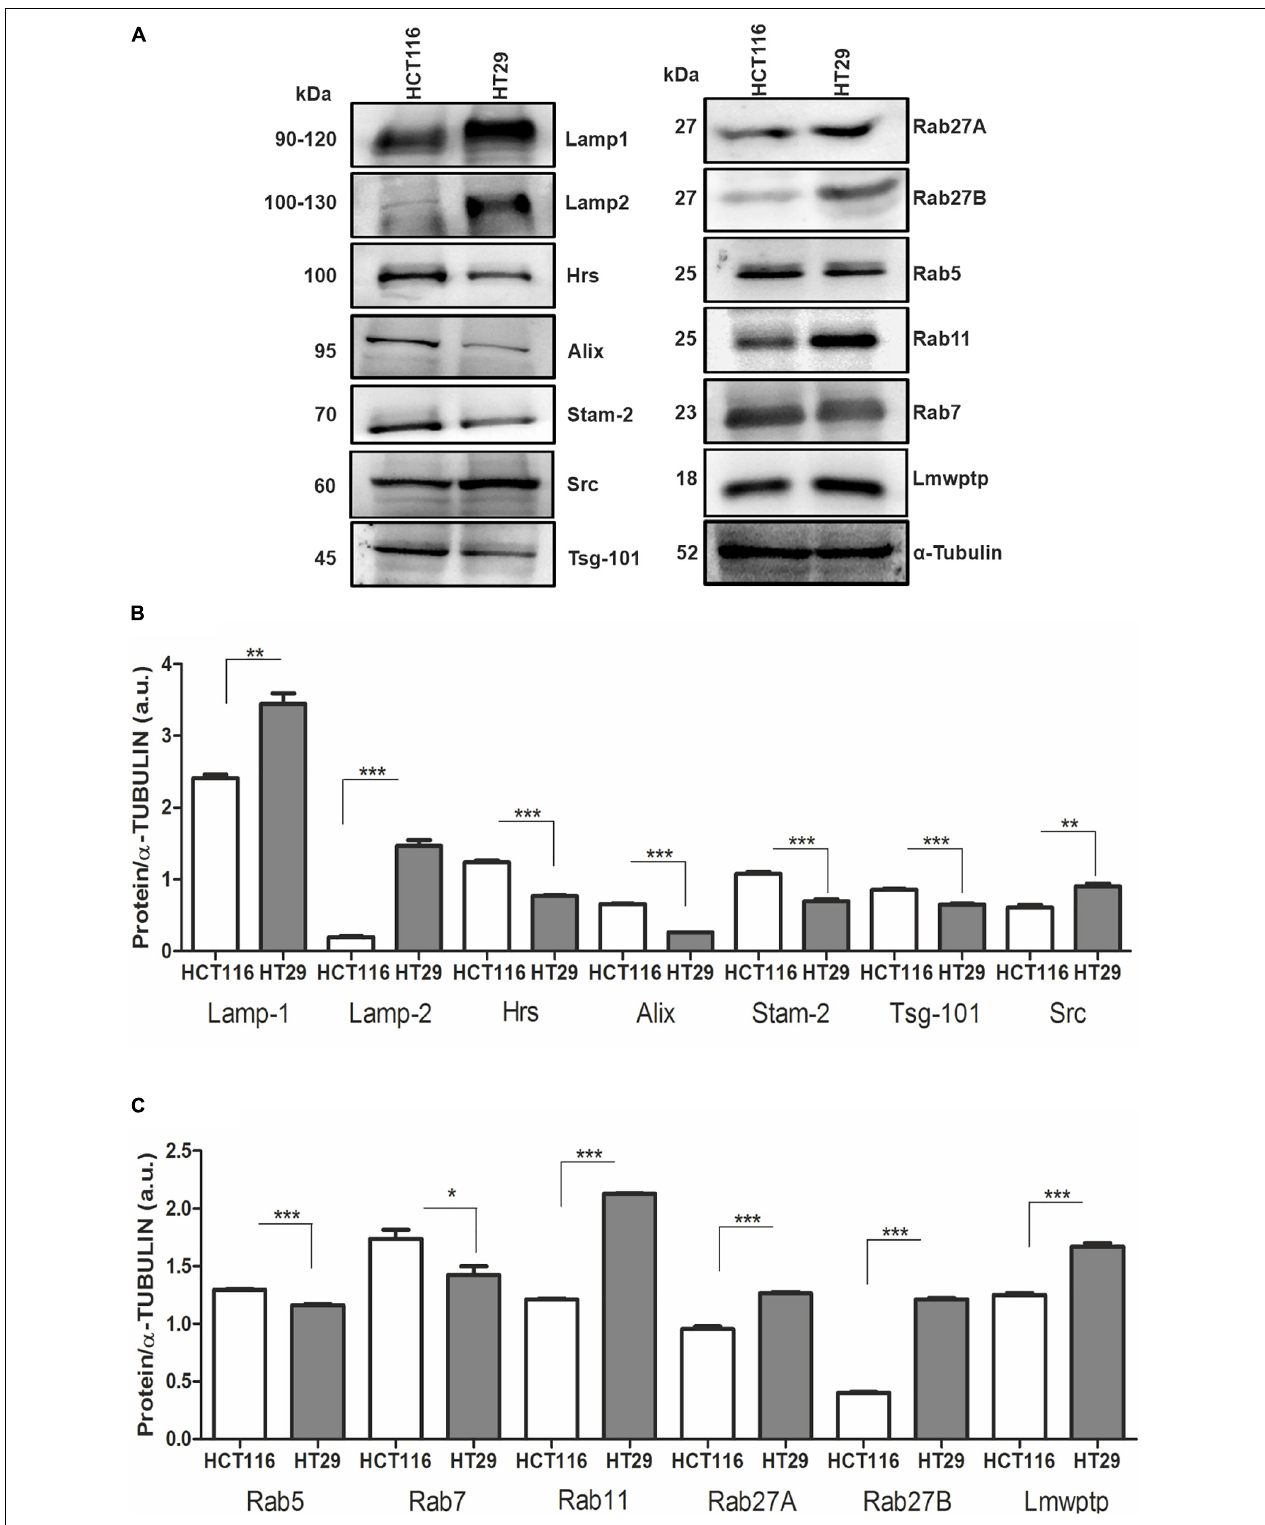
FIGURE 2 | Protein profile from HCT116 and HT29-sEV donor cells. (A) Representative images of Western blotting analysis performed for the indicated proteins. α -Tubulin serves as a loading control. (B,C) Densitometry values were corrected for loading controls. ( N = 3 independent experiments). Values are represented as mean ± SEM. * P < 0.05, ** P < 0.01, and *** P < 0.001, assessed with Student t -test.